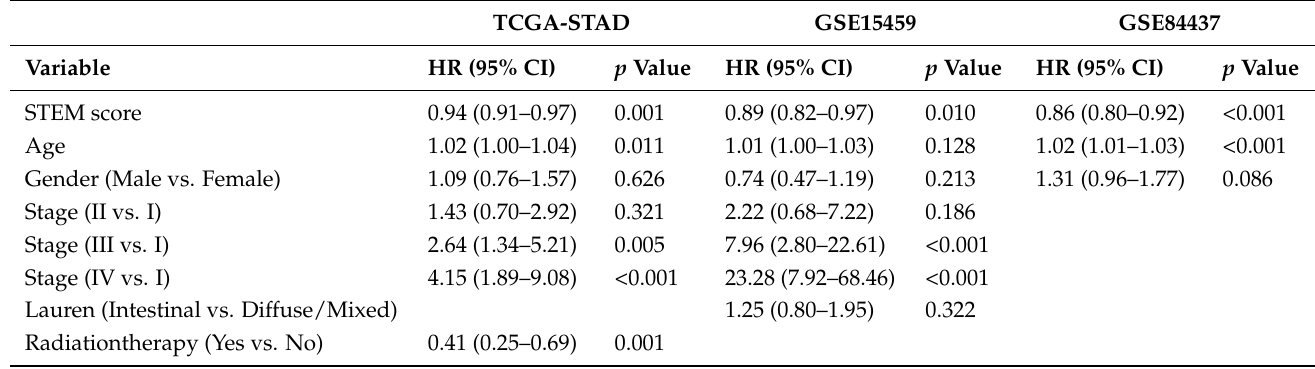
Table 4. Multivariate Cox regression analysis used to examine the independent risk factor of prognosis in three independent validation